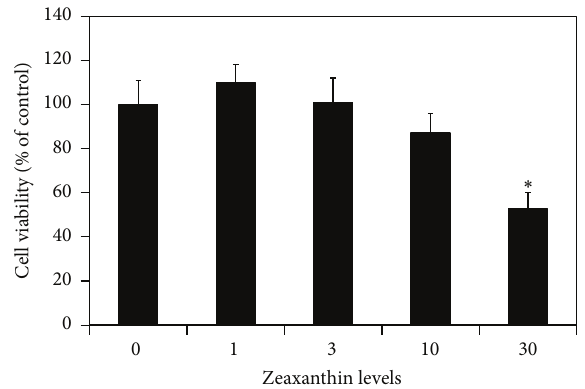
Figure 1: Effects of zeaxanthin on viability of uveal melanoma (UM) cells. Cultured human UM cells (C918) were seeded into 96-well plates and treated with zeaxanthin at different levels. MTT assay was used to determine the cell viability (see Material and Methods). Zeaxanthin only significantly affected the cell viability of UM cells (expressed as percentage of the controls) at 30 𝜇 M ( 𝑛 = 3 , 𝑃 > 0.05 ). ∗ 𝑃 < 0.05 , versus control (cells cultured without